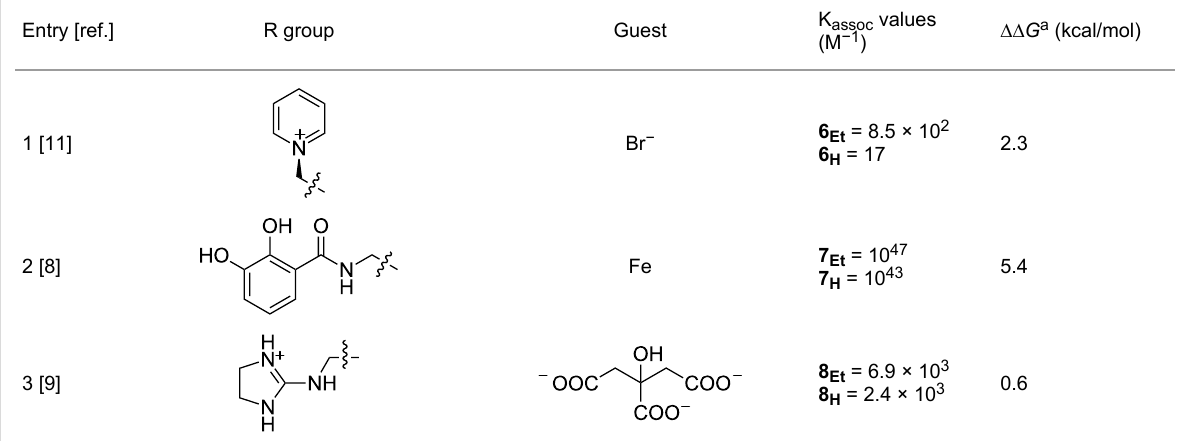
Table 1: Affinity comparisons of ethyl-substituted and unsubstituted hosts.